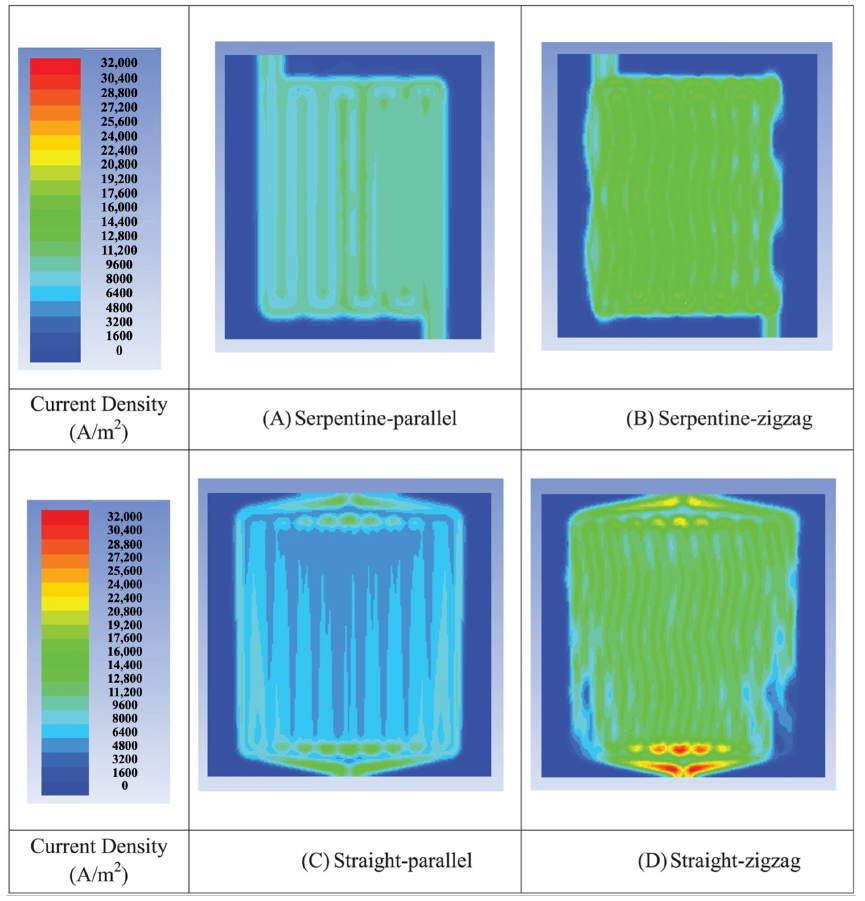
Figure 11. The current density distribution: ( A ) serpentine; ( B ) serpentine zigzag; ( C ) parallel; ( D ) parallel zigzag